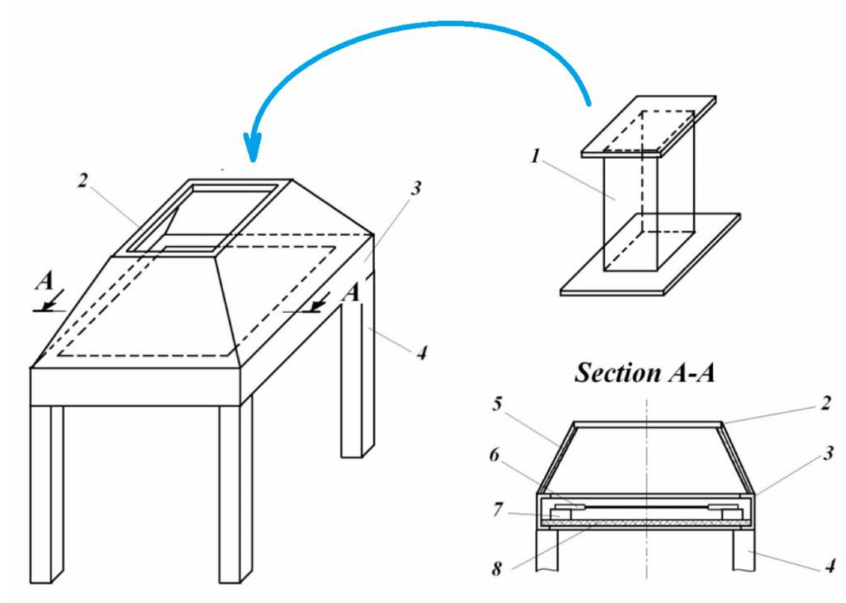
Figure 3. The stand assembled.